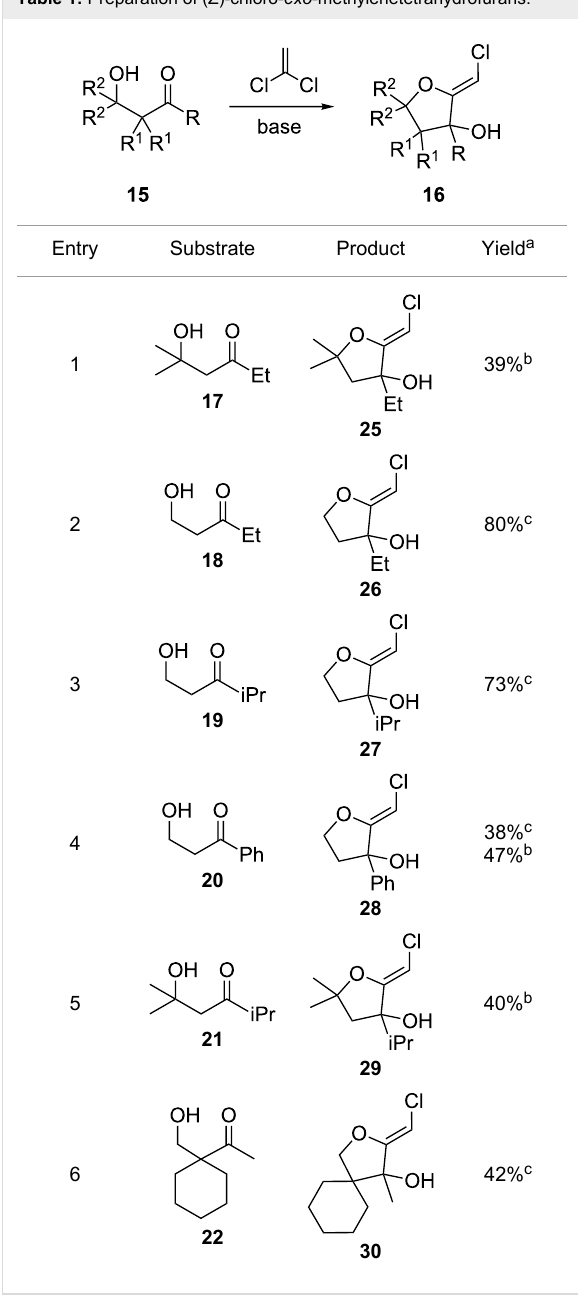
Table 1: Preparation of (Z)-chloro- exo -methylenetetrahydrofurans.